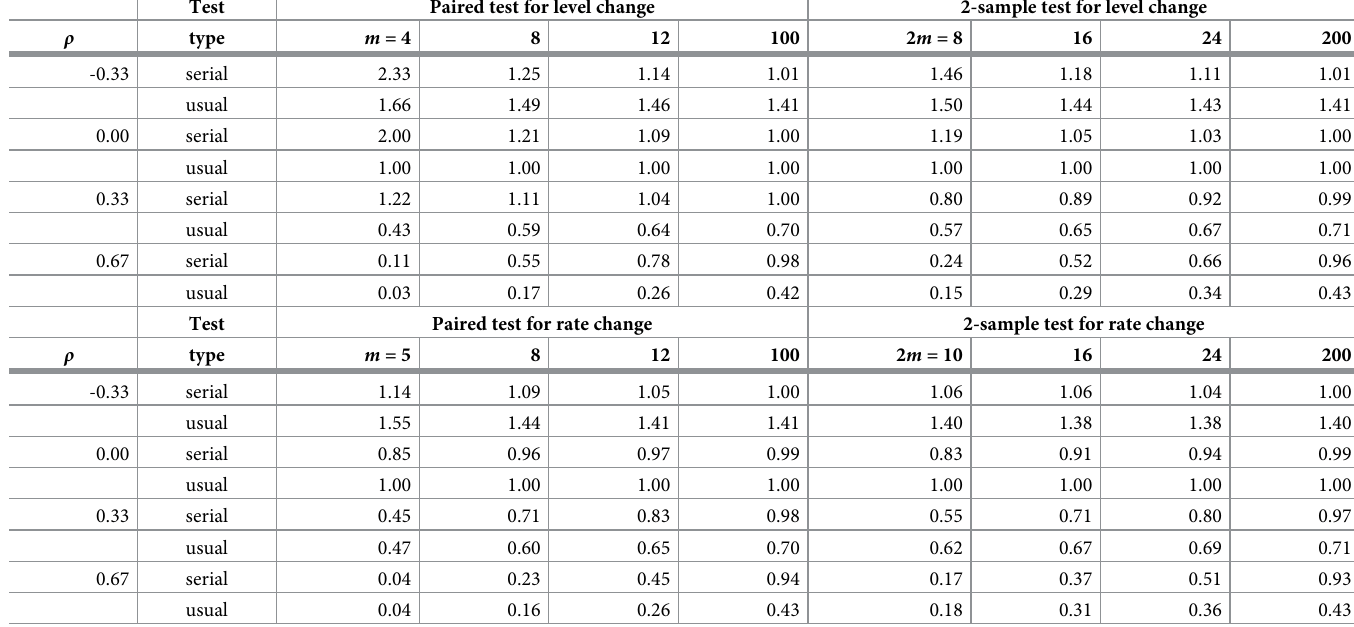
Table 3. Factors by which the expected margin of error for a 90% confidence interval (95% one-sided confidence limit) is overestimated or underestimated for select sample sizes ( m